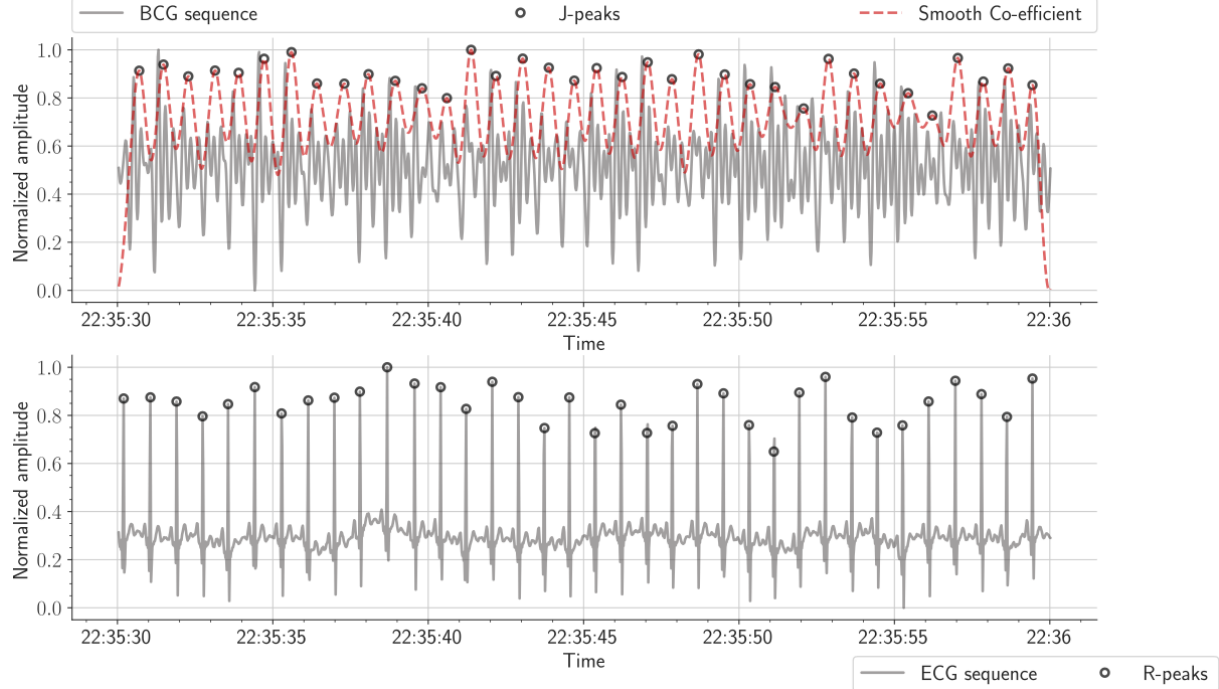
Figure 3. The first row displays a 30-second ballistocardiogram signal and the fourth-level smooth coefficient. The second row displays the equivalent electrocardiogram signal. ECG: